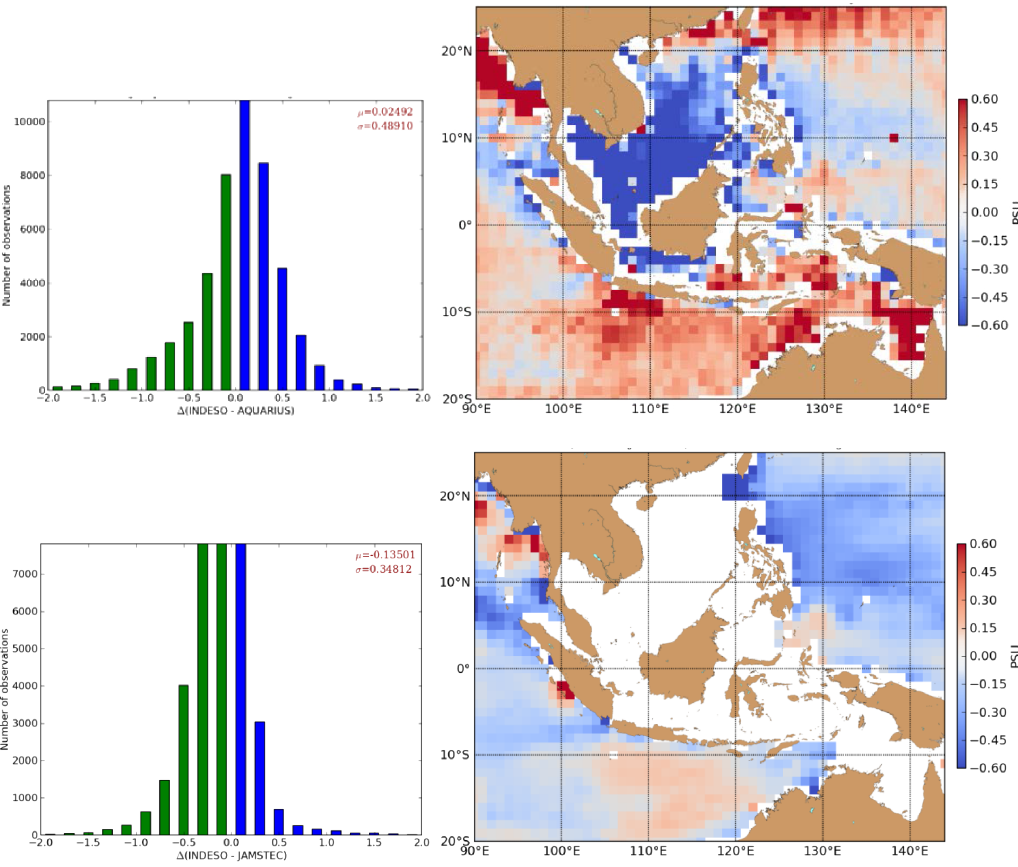
Figure 7. Mean bias (PSU) of the INDO12 SSS (monthly means) relative to Aquarius L3 (V3.0) (top) and JAMSTEC (ARGO + TRITON + CTD) (bottom) from August 2011 to December